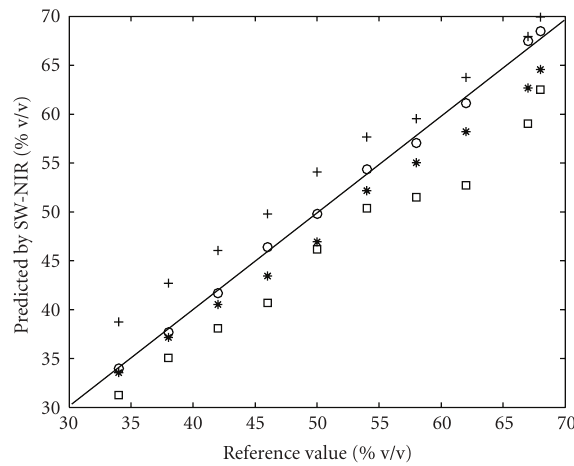
Figure 5: Reference value versus SW-NIR-predicted value by using 25 ◦ C model. Circle: validation set at 25 ◦ C; Plus: validation set at 15 ◦ C; Star: validation set at 35 ◦ C; Square: validation set at 40 ◦ C.